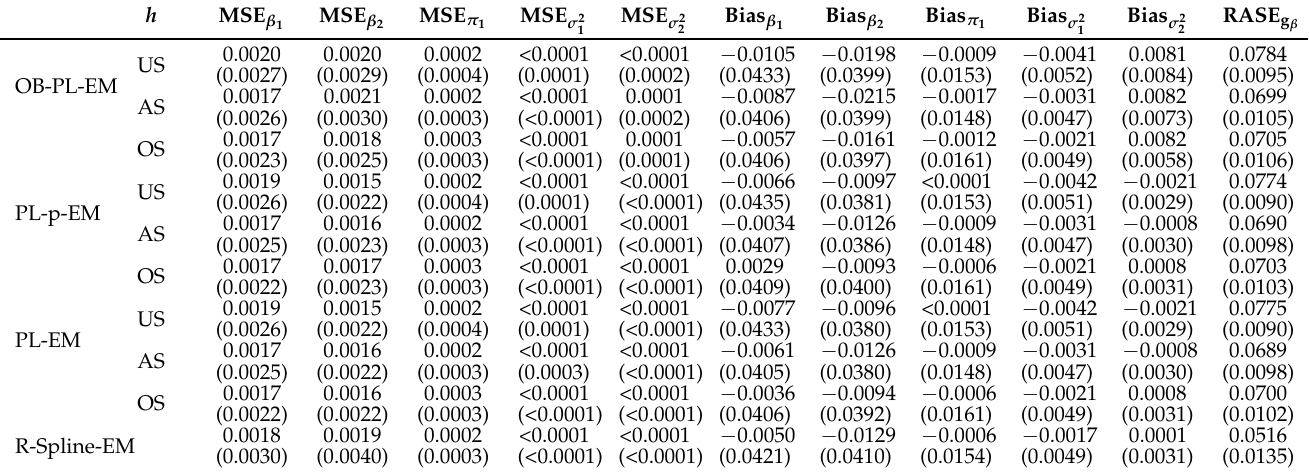
Table 5. Averages (and standard deviations) of the performance measures for n = 1000.